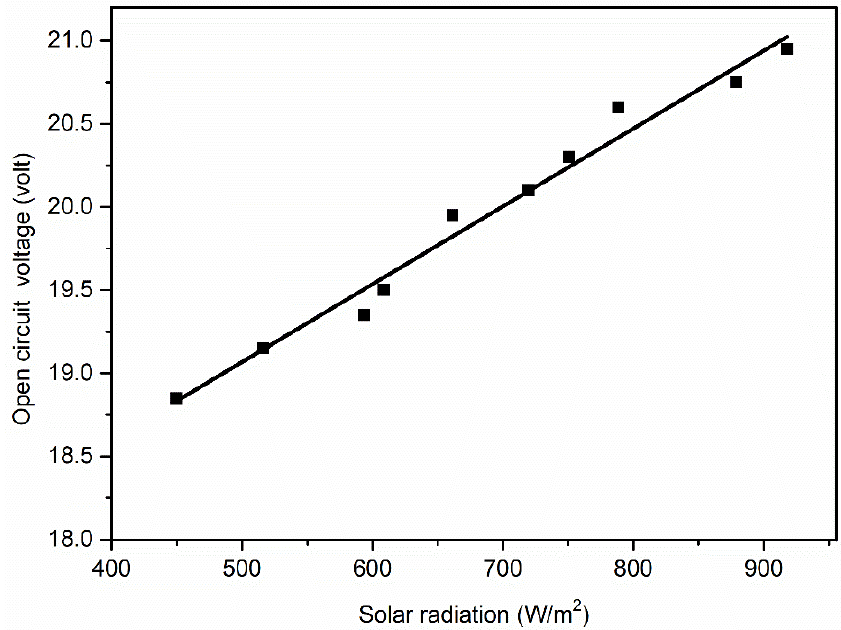
Figure 10. Output voltage with solar irradiance.